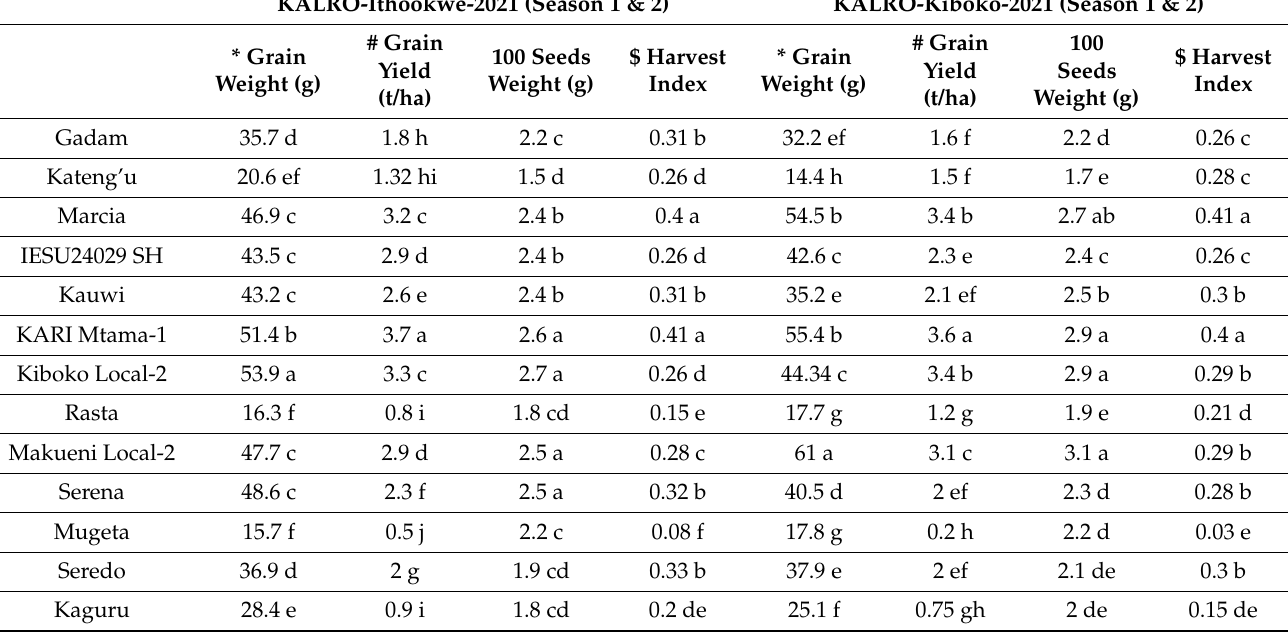
Table 8. Grain weight, grain yield, 100 seed weight and harvest index of sorghum genotypes at KALRO Ithookwe and Kiboko field sites for two